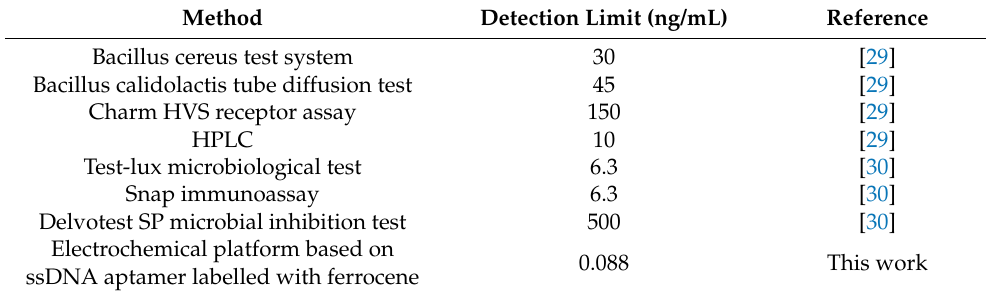
Table 3. Comparison of different methods for tetracycline detection in cow milk samples.